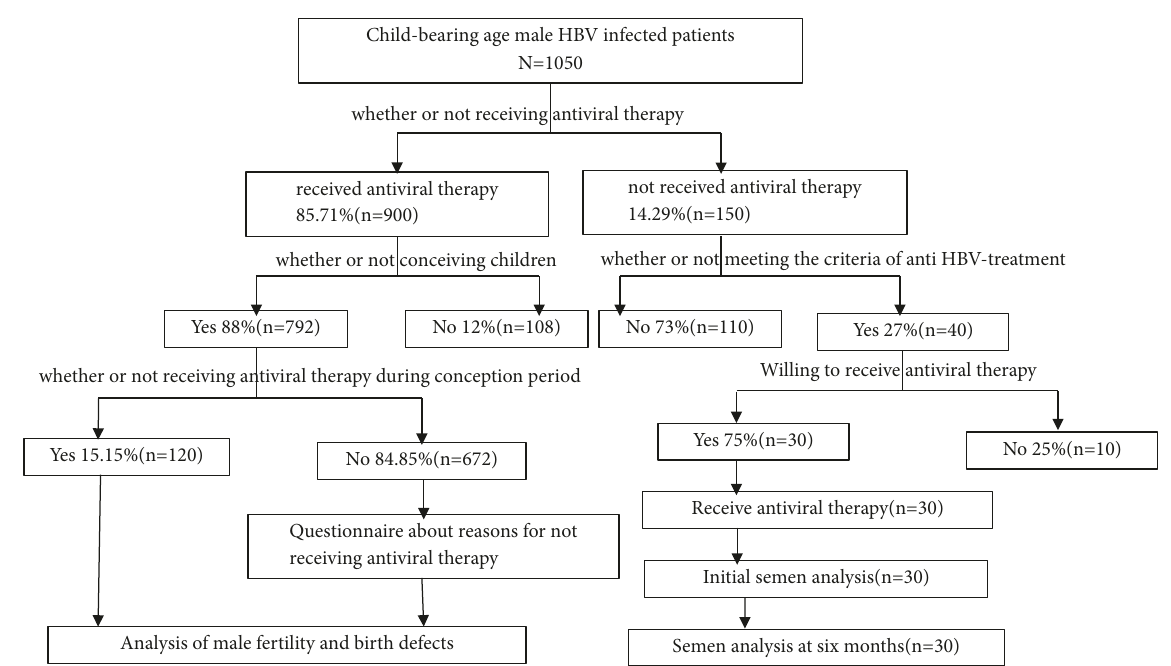
Figure 1: Study design and patient screening flow chart. We enrolled 1050 patients with HBV infection and 30 patients were assigned to anti-HBV therapy and semen analysis. HBV: hepatitis B